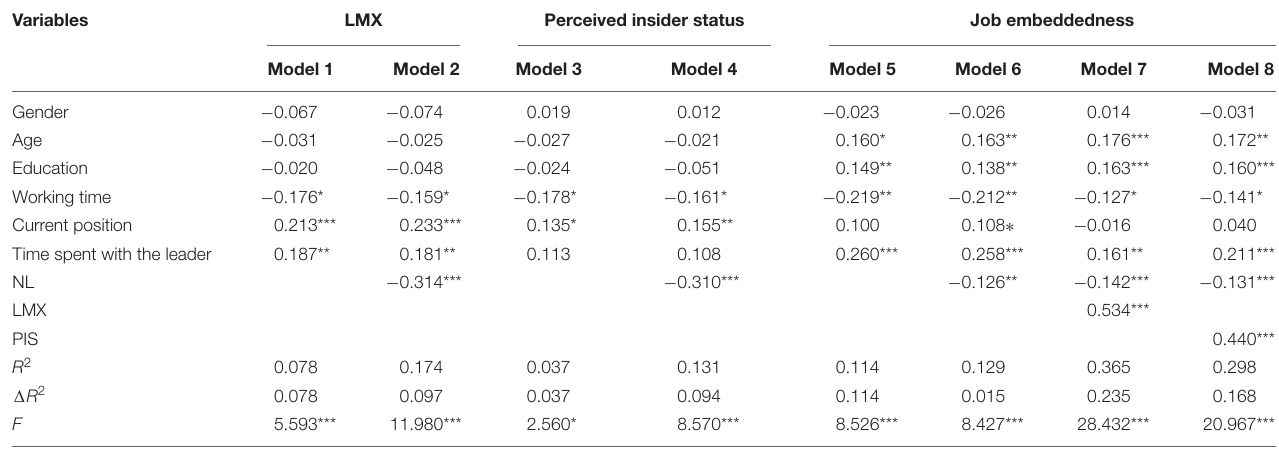
TABLE 3 | Results of hierarchical regression analysis.